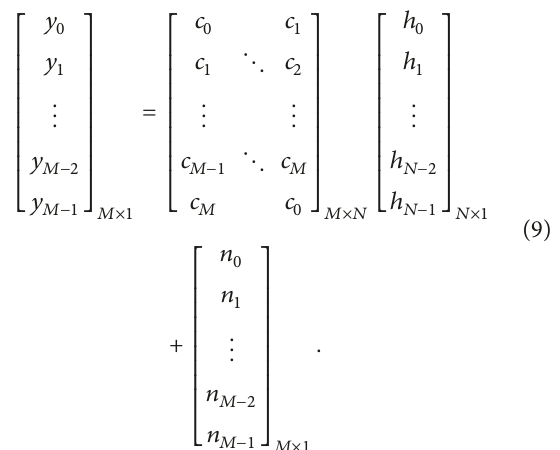
Figure 5: Sampling process of CS.